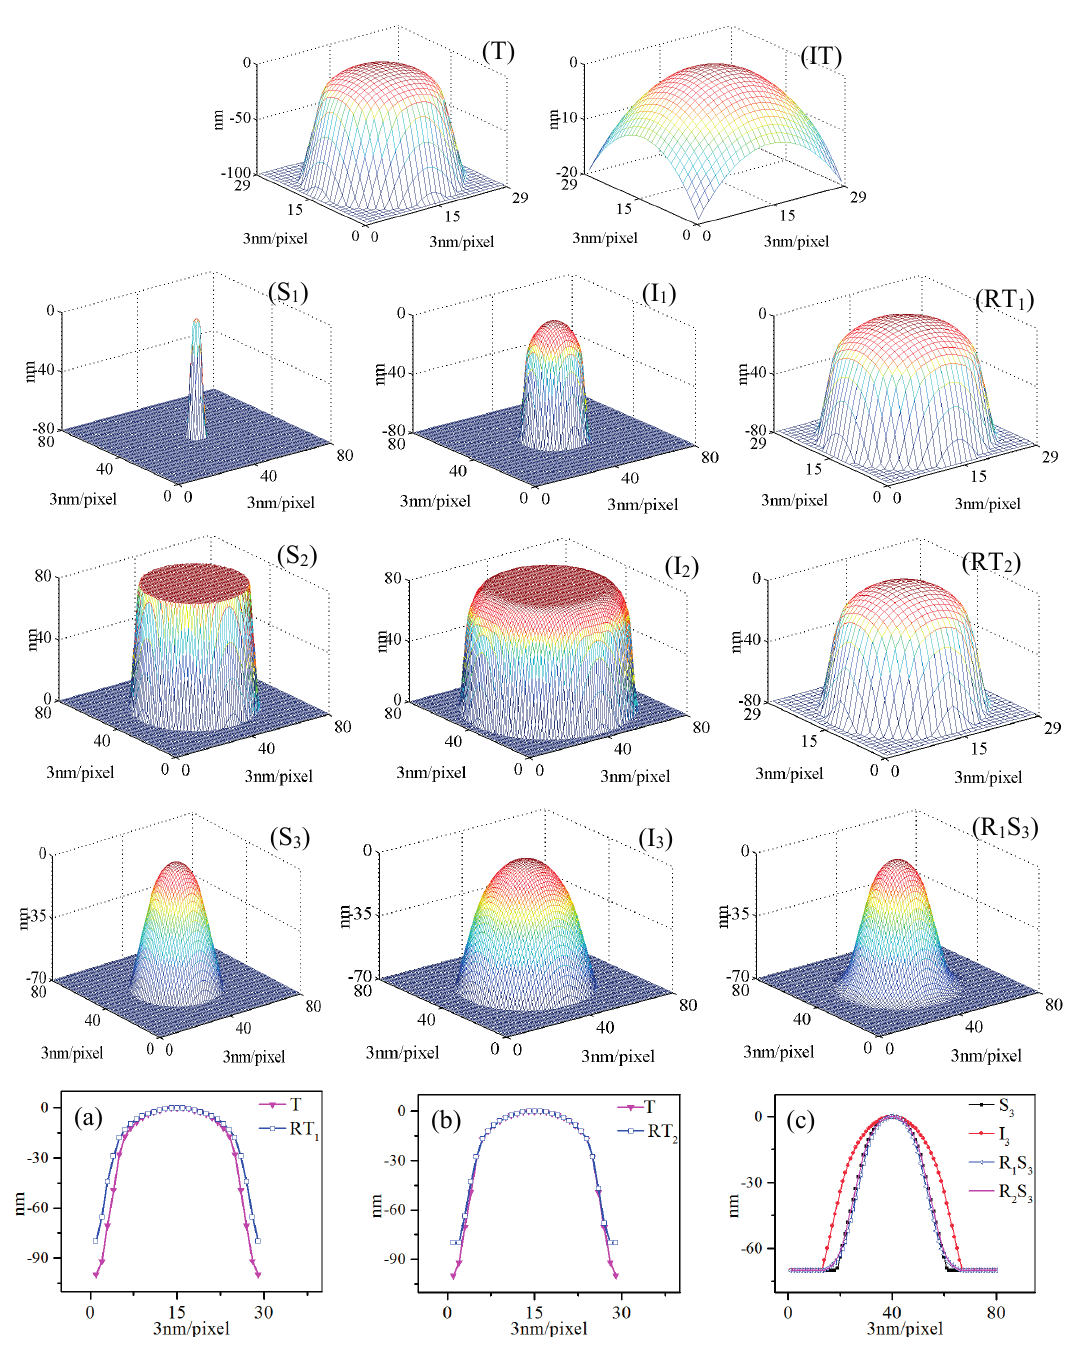
Figure 6. ( T ) A simulated 3D tip. ( IT ) an initial 3D tip for S 2 . ( S ) is the sample needed to be reconstructed. ( I structures for BTR. ( S 3 obtained by dilating sample surface with the simulated tip. ( RT reconstructed tips produced by using the created image I 1 and I 2 in BTR algorithm. ( R the reconstructed sample surface produced by using the reconstructed tip (RT 1 ) in erosion algorithm. ( a ) The comparisons of cross sections through the apex of the actual tip (T) and the tip reconstructed from S 1 (RT 1 ); ( b ) The comparisons of cross sections through the apex of the actual tip (T) and the tip reconstructed from S 2 (RT 2 ); ( c ) The comparisons of cross sections through the apex of the actual surface of S 3 , image (I 3 ), reconstructed image using RT 1 (R 1 S 3 ) and reconstructed image using RT 2 (R 2 S 3